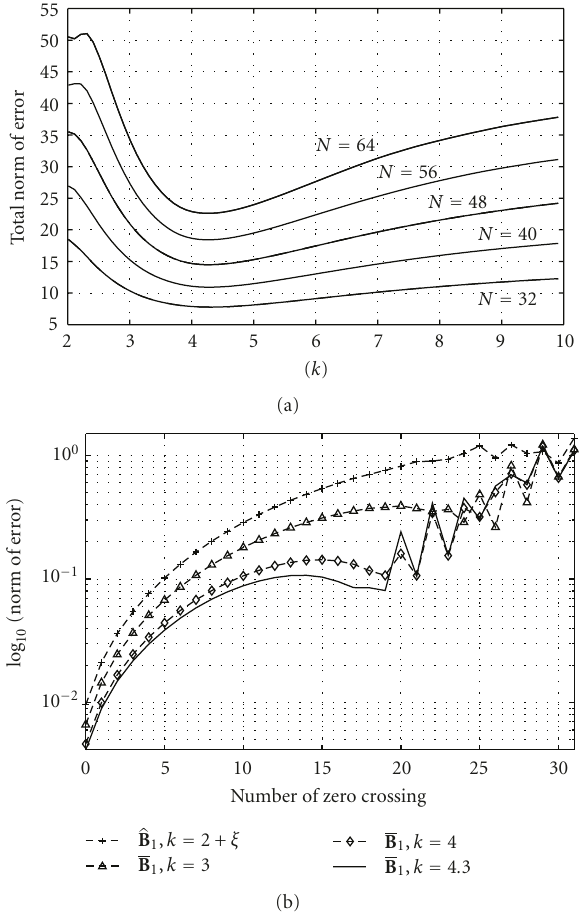
Figure 2: (a) The total norm of error versus k in B 1 for N = 32, 40, 48, 56, and k = 4 . 3. The total norm of error is minimum when k ≈ 4 . 3. (b) Error norms between the discrete Hermite-Gaussian like eigenvectors and the samples of the Hermite-Gaussian functions when B 1 for k = 3, 4, and k = 4 . 3 and (cid:14) B 1 with N = 32.